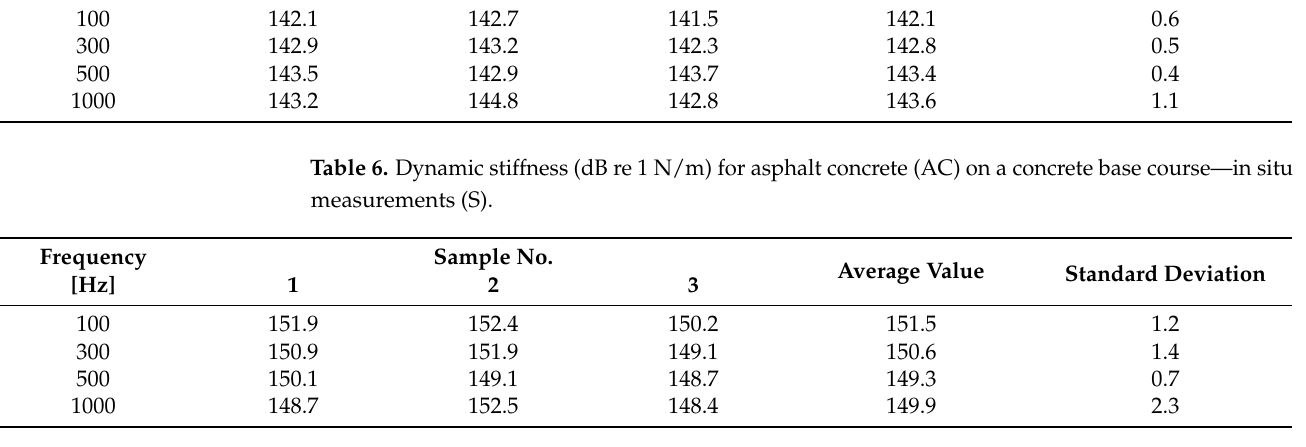
Table 7. Dynamic stiffness (dB re. 1 N/m) for PSMA5 poroelastic layer with PA11 as binder course— laboratory measurements